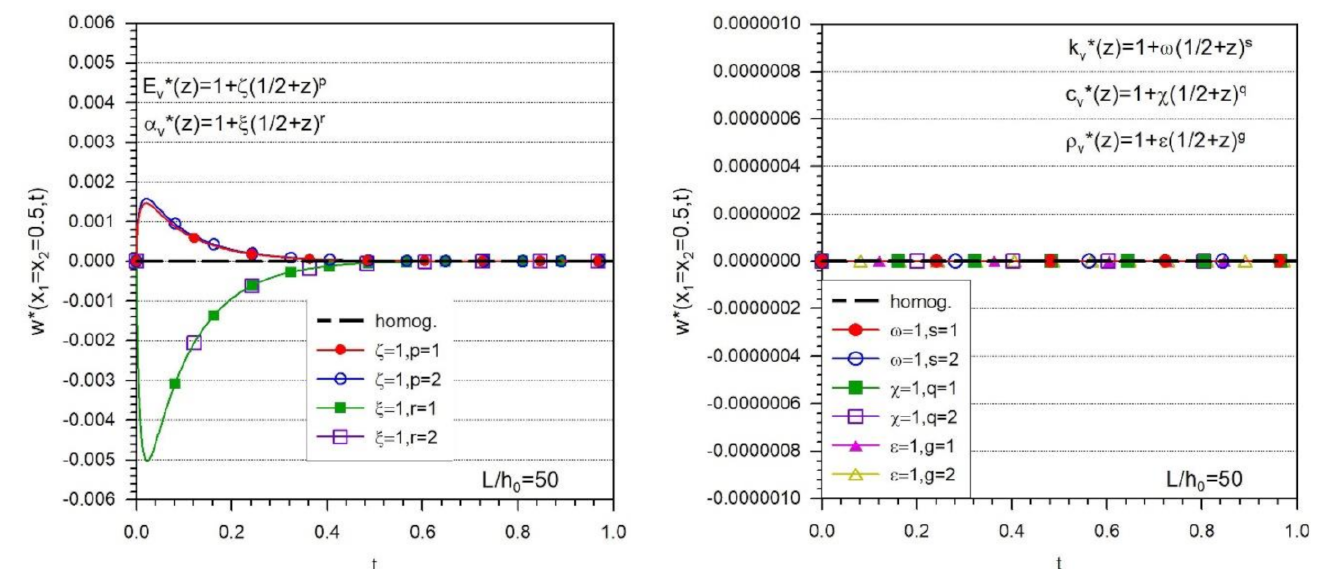
Figure 13. Time variations of the deflections in homogeneous as well as FGM